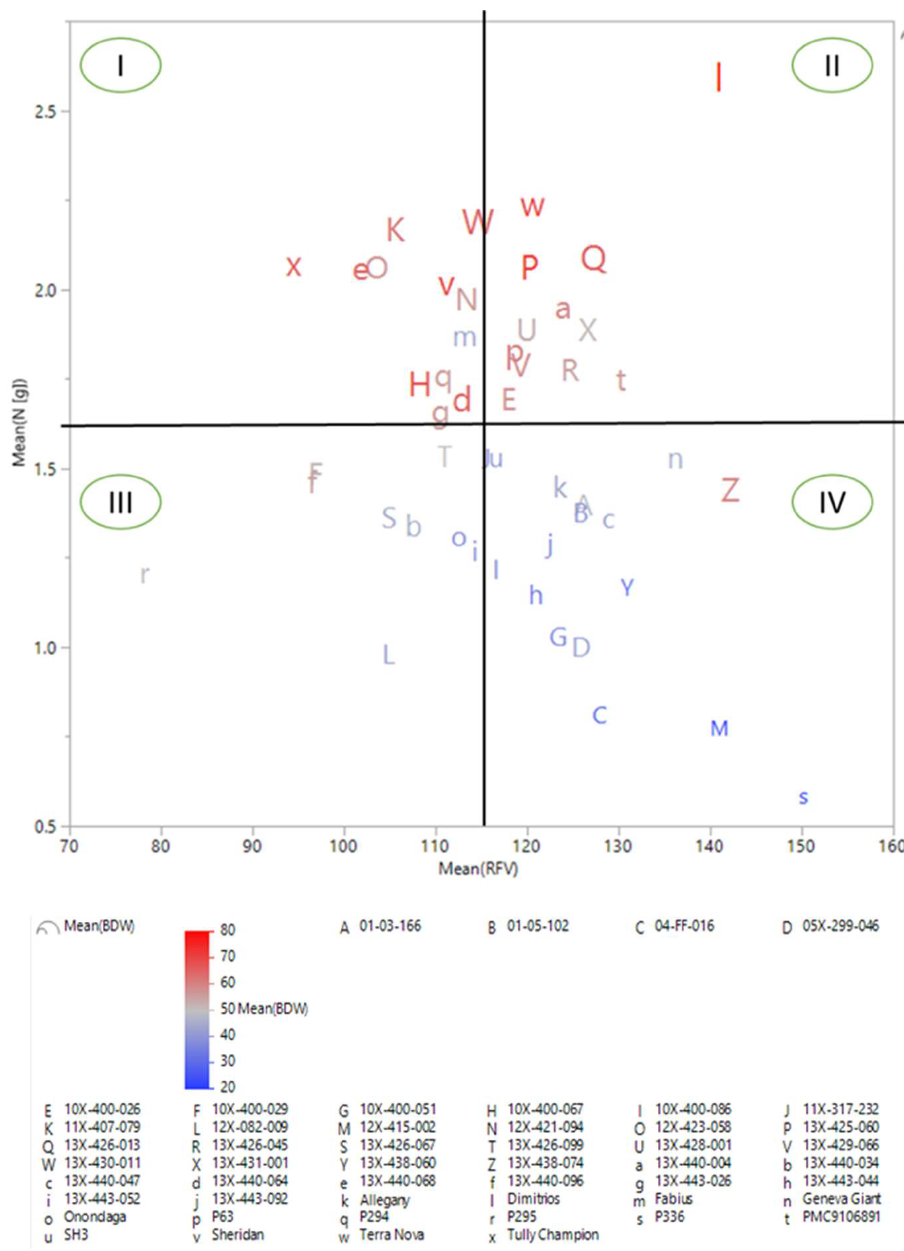
Figure 6. Performance of N uptake with relative feed value (RFV) under high N fertilizer. Quadrant (Q)I, high performance, low quality, QII high performance and quality, QIII, low performance and quality, QIV, low performance, high quality.